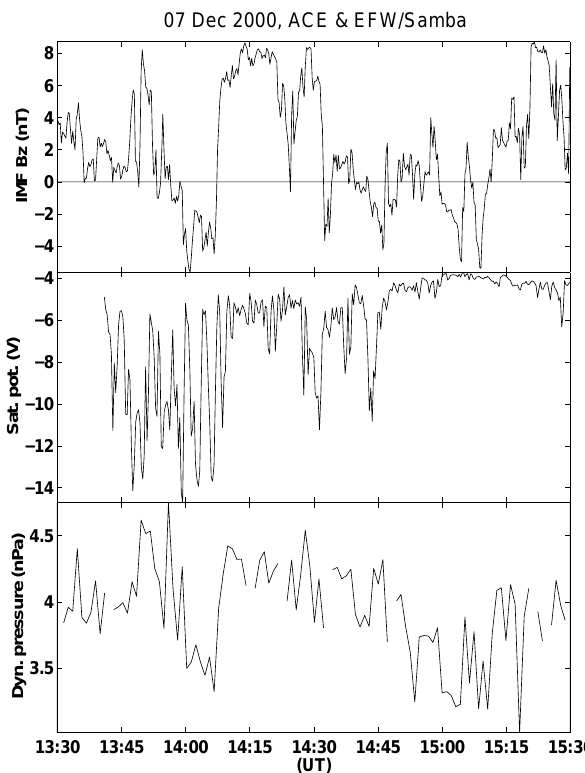
Fig. 8. (Top panel) IMF B Z as recorded by ACE (time shifted by 80min), (middle panel) negative of the satellite potential of Samba (spacecraft 3), and (bottom panel) dynamic pressure based on ACE/SWEPAM proton density and speed